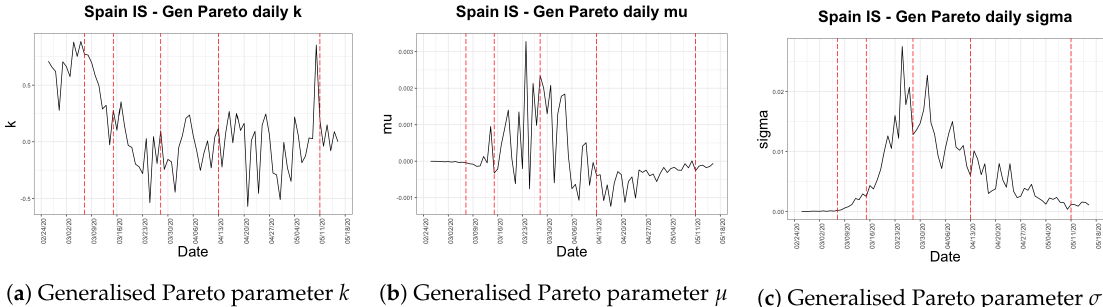
Figure 7. Time series for Spain infection speed generalised Pareto